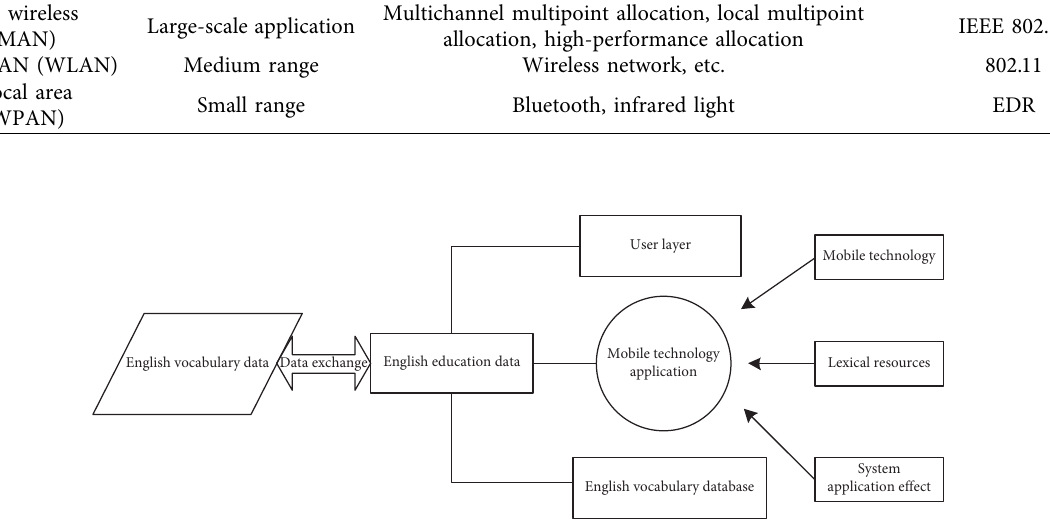
Table 1: Mobile communication deployment mode selected in the college English vocabulary teaching system. Project